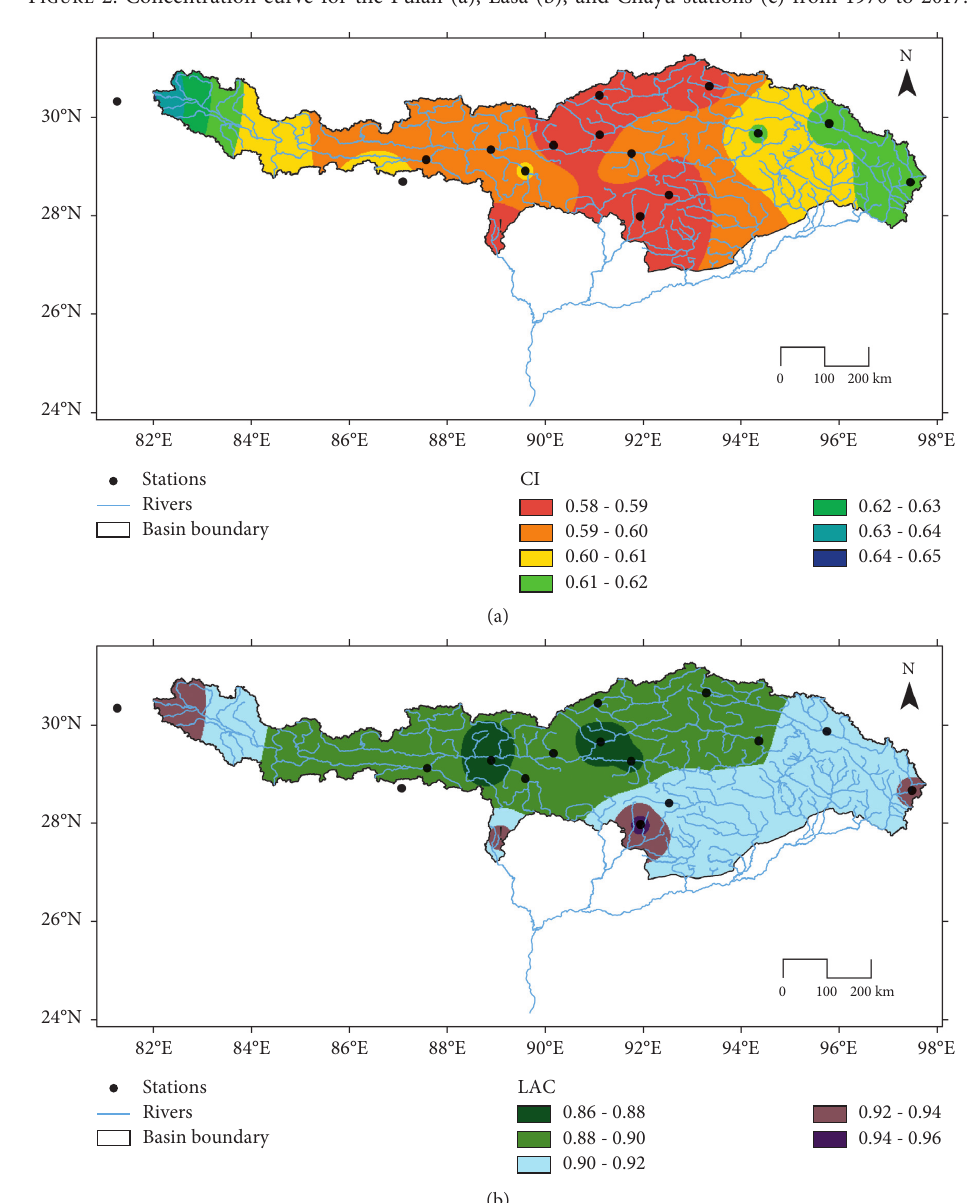
Figure 3: Spatial distribution of annual CI (a) and LAC (b) values.